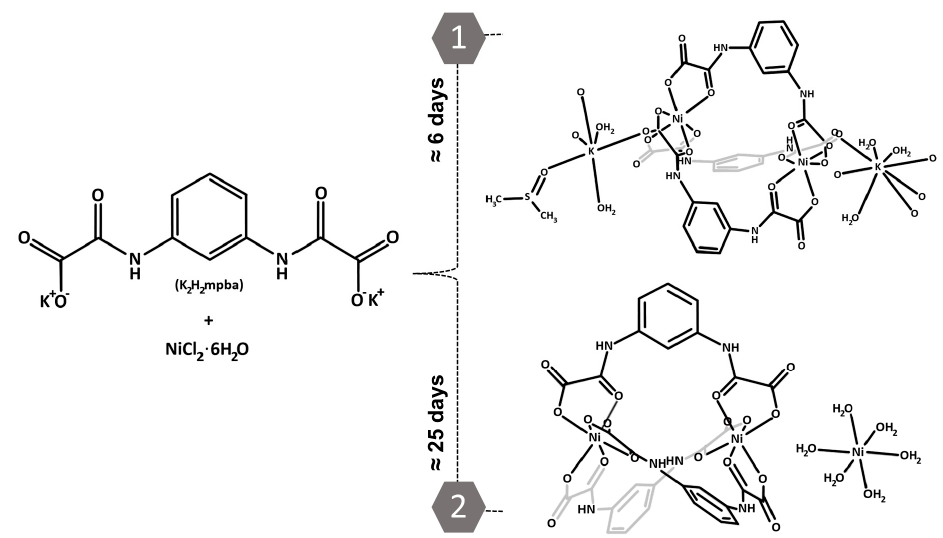
Scheme 1. Synthetic conditions for the preparation of 1 and 2 . Layers in the test tubes: H 2 O